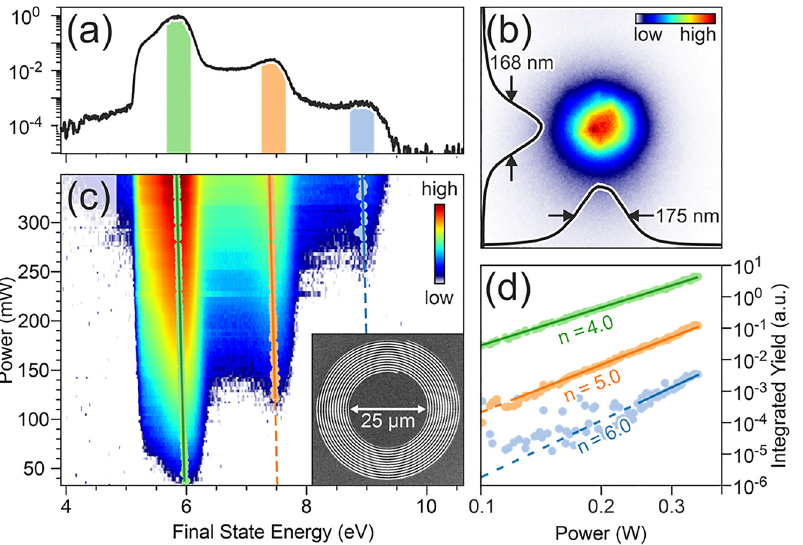
Figure 2: (a) Electron emission spectrum from the focus in the center of the spiral at an average laser power of 349 mW. The colored regions indicate the integration areas analyzed in panel (d). (b) PEEM image of the focus in the center of the spiral. The corresponding marginal distributions in x- and y-direction are plotted as red curves. (c) Logarithmic false-color representation of the energy-resolved electron emission yield as function of average laser power. The inset in panel (c) shows a scanning electron micrograph of the used spiral. (d) The yield-scaling of the emission peaks in panel (a) with the average laser power. The solid lines are power-law fits to the data with the indicated